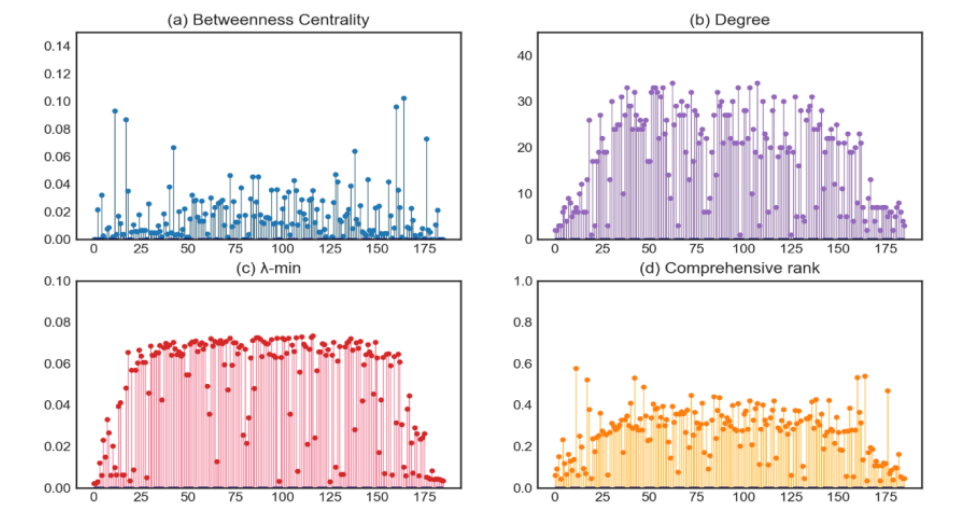
Figure 4. Ranking of key station nodes in HNSN. ( a ) The betweenness centrality of the station nodes. ( b ) The degree of the station nodes in HNSN. ( c ) The minimum eigenvalues of the deleted Laplacian matrix after removing the station nodes. ( d ) The comprehensive scores of the station